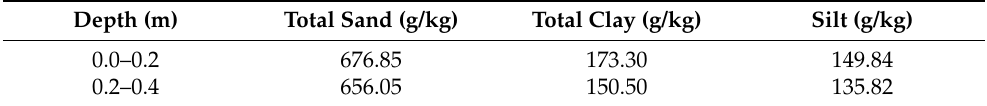
Table 1. Soil granulometric analysis at depths of 0.0–0.2 and 0.2–0.4 m.